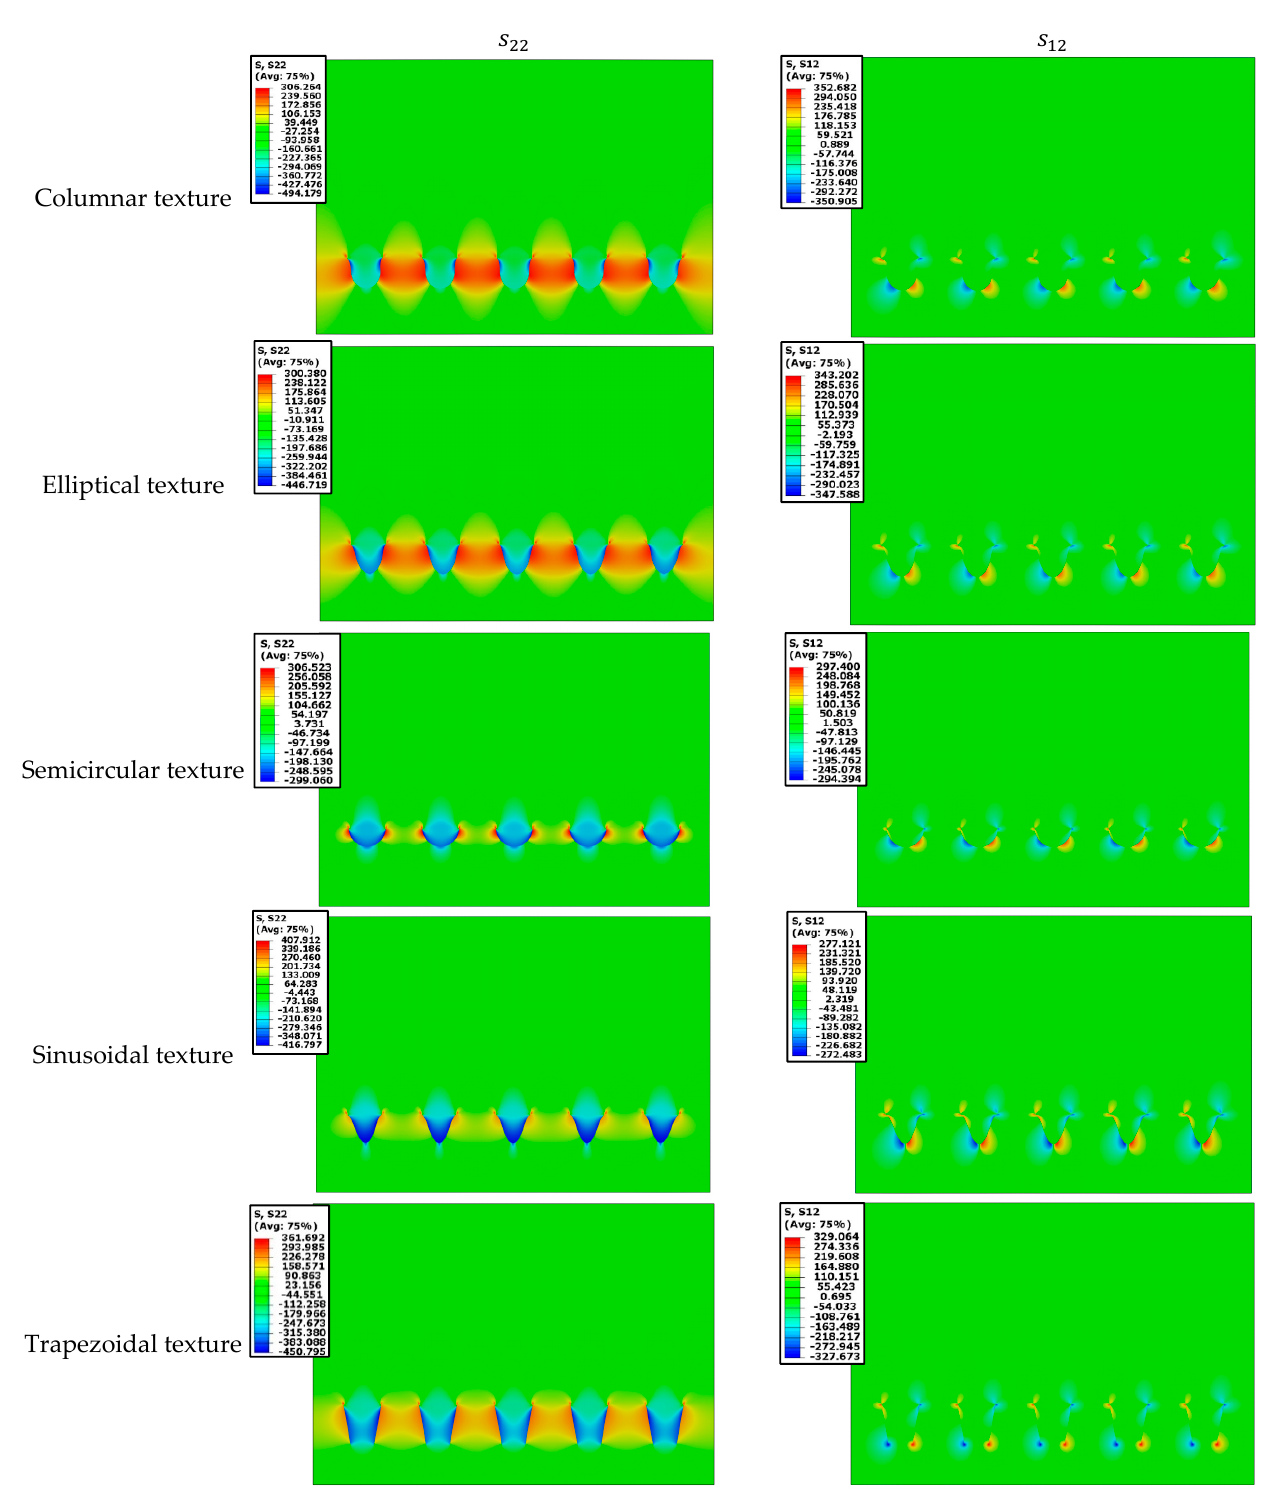
Figure 6. Stress field distribution of five texture coatings after one thermal cycle: 𝑠 (cid:2870)(cid:2870) and 𝑠 (cid:2869)(cid:2870) .